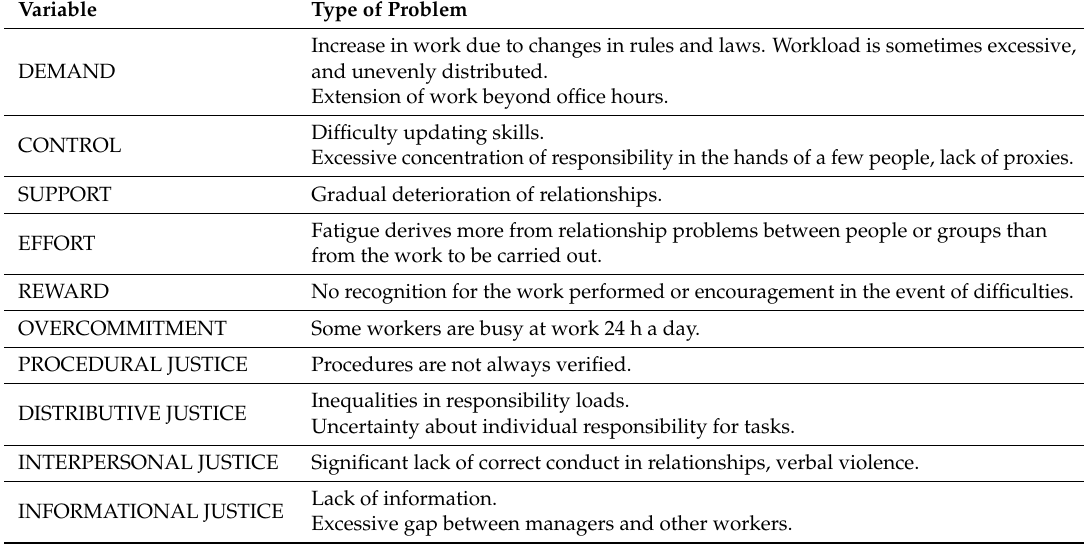
Table 1. Work-related problems identified by